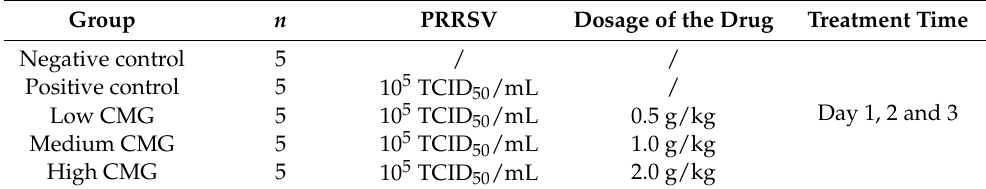
Figure 2. Inhibition rate to PRRSV of all four MCFAs. **** p < 0.0001, ns indicates no significant difference between the two groups. Table 1. Piglet grouping, virus challenge, and administration